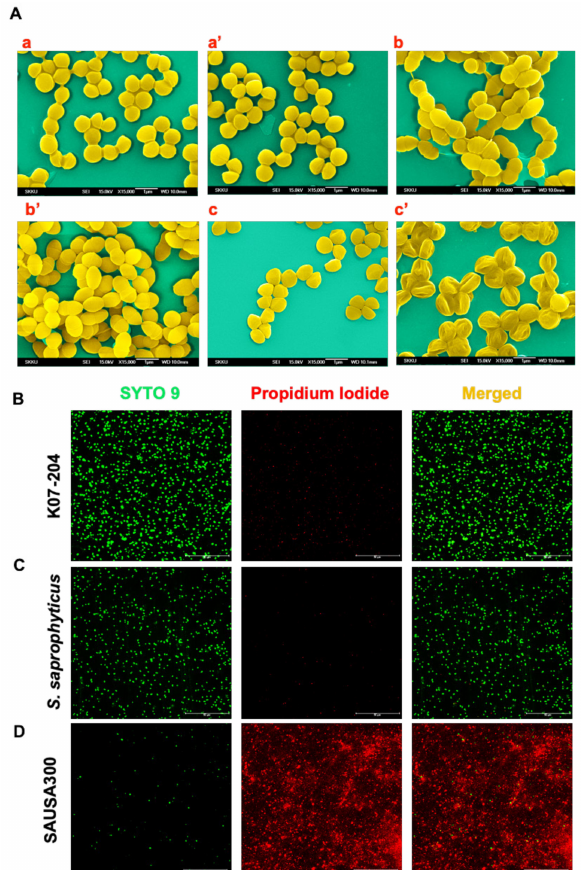
Figure 3. Confirmation of lysostaphin-mediated alteration in the cell wall and consequent cell death. ( A ) Scanning electron microscopy (SEM) to visualize the alteration in the cellular morphology showing staphylococcal cells without lysostaphin treatment wherein K07-204 ( a ); S. saprophyticus ( b ); and SAUSA300 ( c ); and after lysostaphin treatment K07-204 ( a’ ); S. saprophyticus ( b’ ); and SAUSA300 ( c’ ). Both K07-204 and S. saprophyticus ( lys r ) did not show any alteration, while the SAUSA300 ( lys s ) cells were shrunk upon lysostaphin treatment due to the catalytic cleavage activity of lysostaphin; ( B – D ) Confocal microscopy images of live / dead staining of ST72 resistant isolates and its comparison with SAUSA300 to assess the consequent proportion of live / dead staphylococcal cells, wherein SYTO9 stains the total cells (green), whereas propidium iodide (PI) exclusively stains dead cells (red). Both K07-204 ( B ) and S. saprophyticus ( C ) showed a lower number of dead (red) cells compared to SAUSA300 ( D ) upon 2 U of lysostaphin